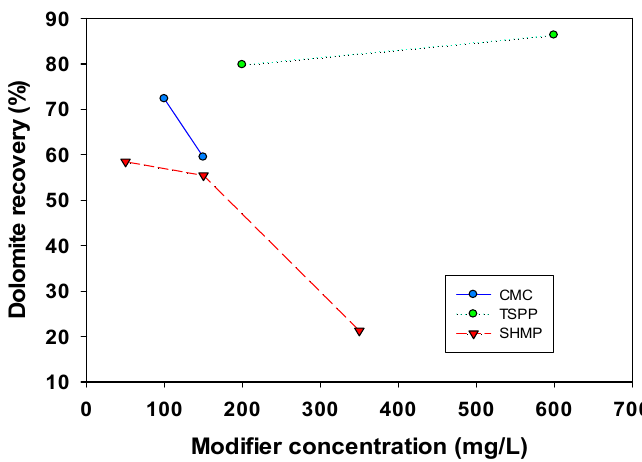
Figure 2. Effect of various modifiers on Mg carbonate flotation in different conditions.